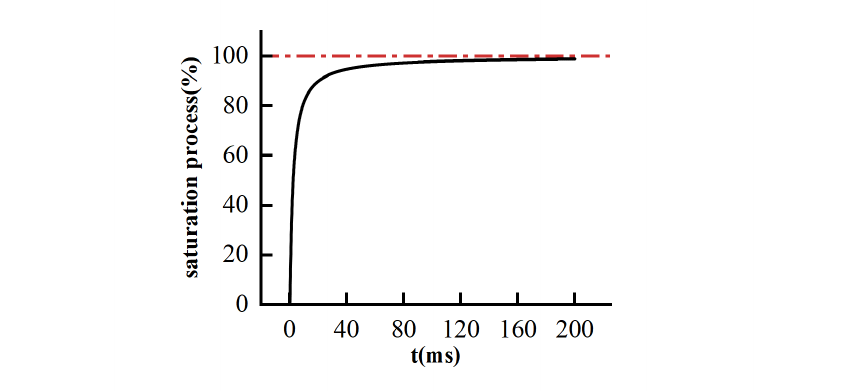
Figure 2. Charging rate of single water